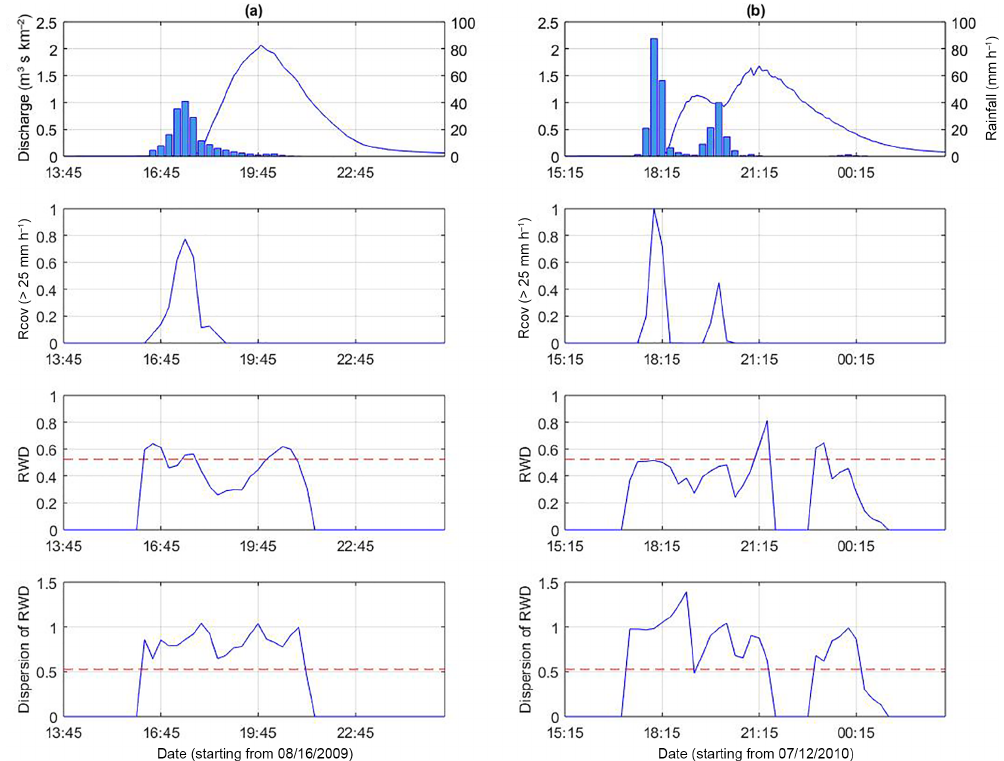
Figure 5. Time series of basin-average rainfall, flow, portion of basin covered by high-intensity rainfall (>25mmh − 1 ), normalized rainfall-weighted flow distance (RWD) and RWD dispersion in Lower LSugar, for two events that occurred on 16 August 2009 (a) and 12 July 2010 (b)